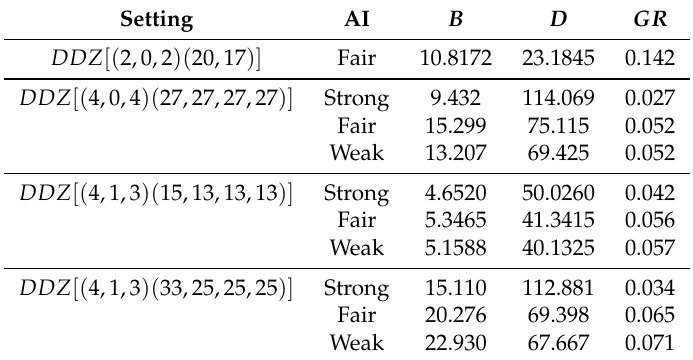
Table 10. The results of simulation performed using different DouDiZhu AIs for various game settings.